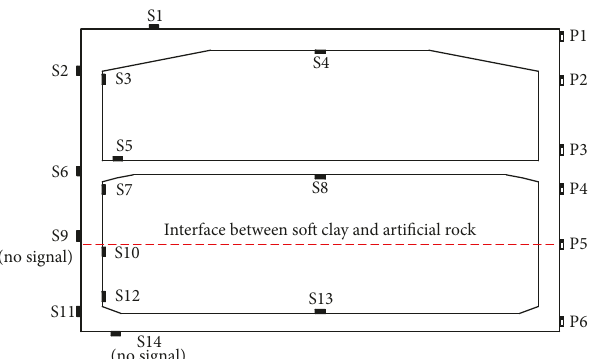
Figure 9: Layout of the strain and soil pressure gauges in the model structure.